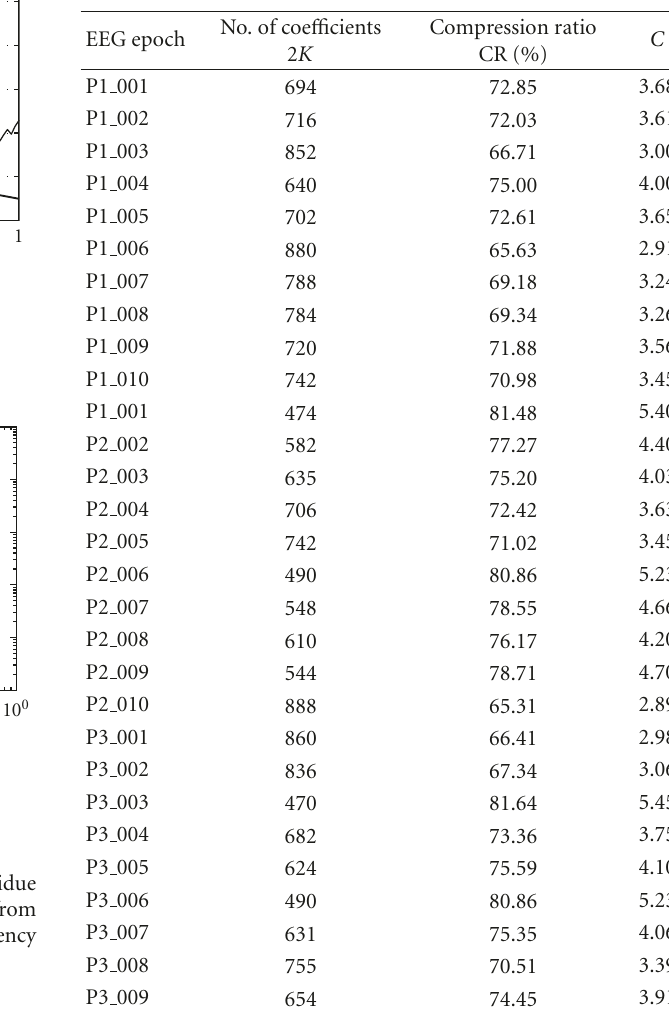
Table 2: The assumed values of 2K, the respective compression ratio CR and